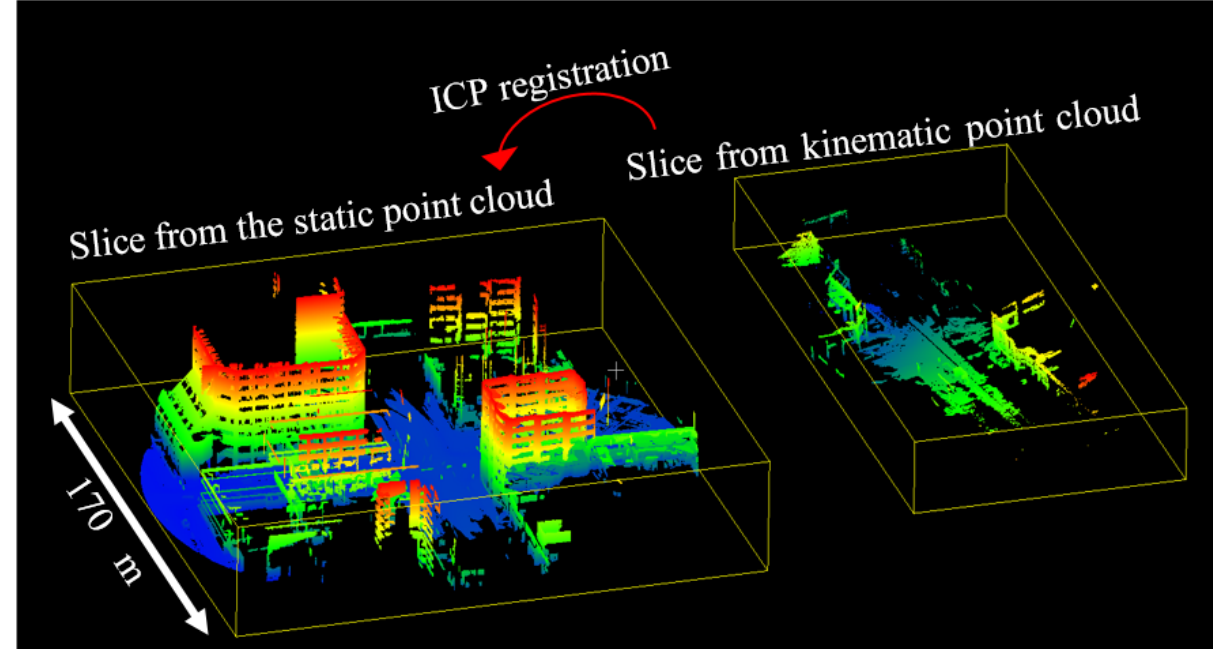
Figure 1. ICP-based accuracy assessment (point cloud color represents height).